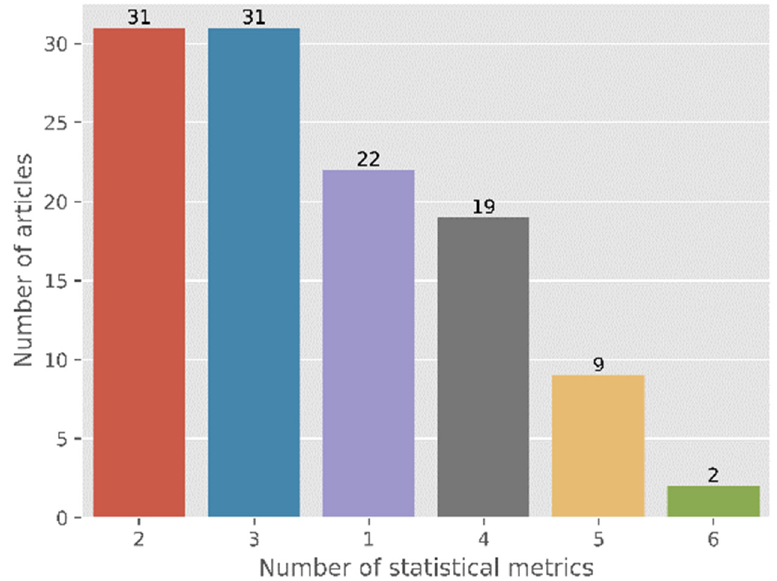
Figure 2. Number of statistical metrics used per article to evaluate the performance of forecasting models (evaluation of 114 articles).